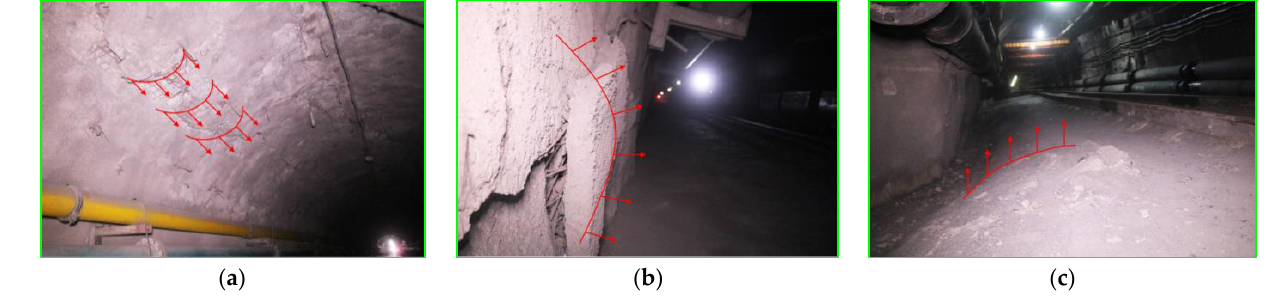
Figure 4. Deformation failure of the surrounding rock in the main roadway. ( a ) the roof; ( b ) the wall; ( c ) the floor.